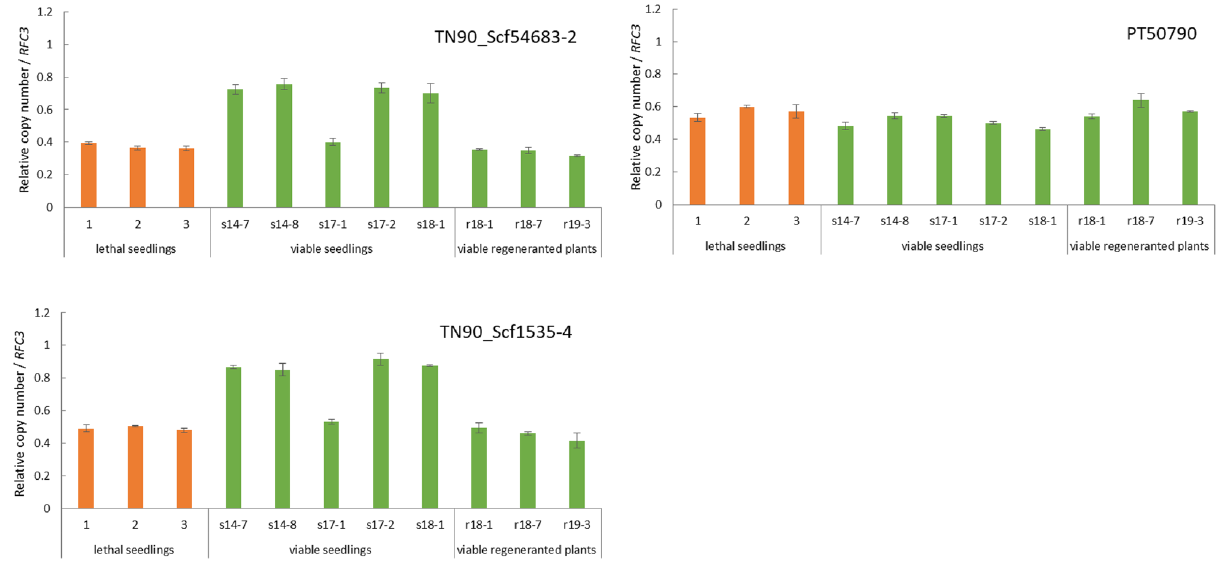
Figure 6. Mean (± SE) of relative copy number of each marker on the Q ′ chromosome in lethal seedlings (No. 1–No. 3), viable seedlings lacking distal part of the Q chromosome (s14-7 ~ 8, s17-1 ~ 2, and s18-1), and viable regenerated plants lacking distal part of the Q chromosome (r18-1, r18-7, and r19-3). Quantitative Real- Time-Polymerase Chain Reaction (qRT-PCR) was used to determine copy number of each region on the Q ′ chromosome relative to that of the RFC3 gene. Data are shown as the mean ± SE from triplicate experiments for each DNA sample.